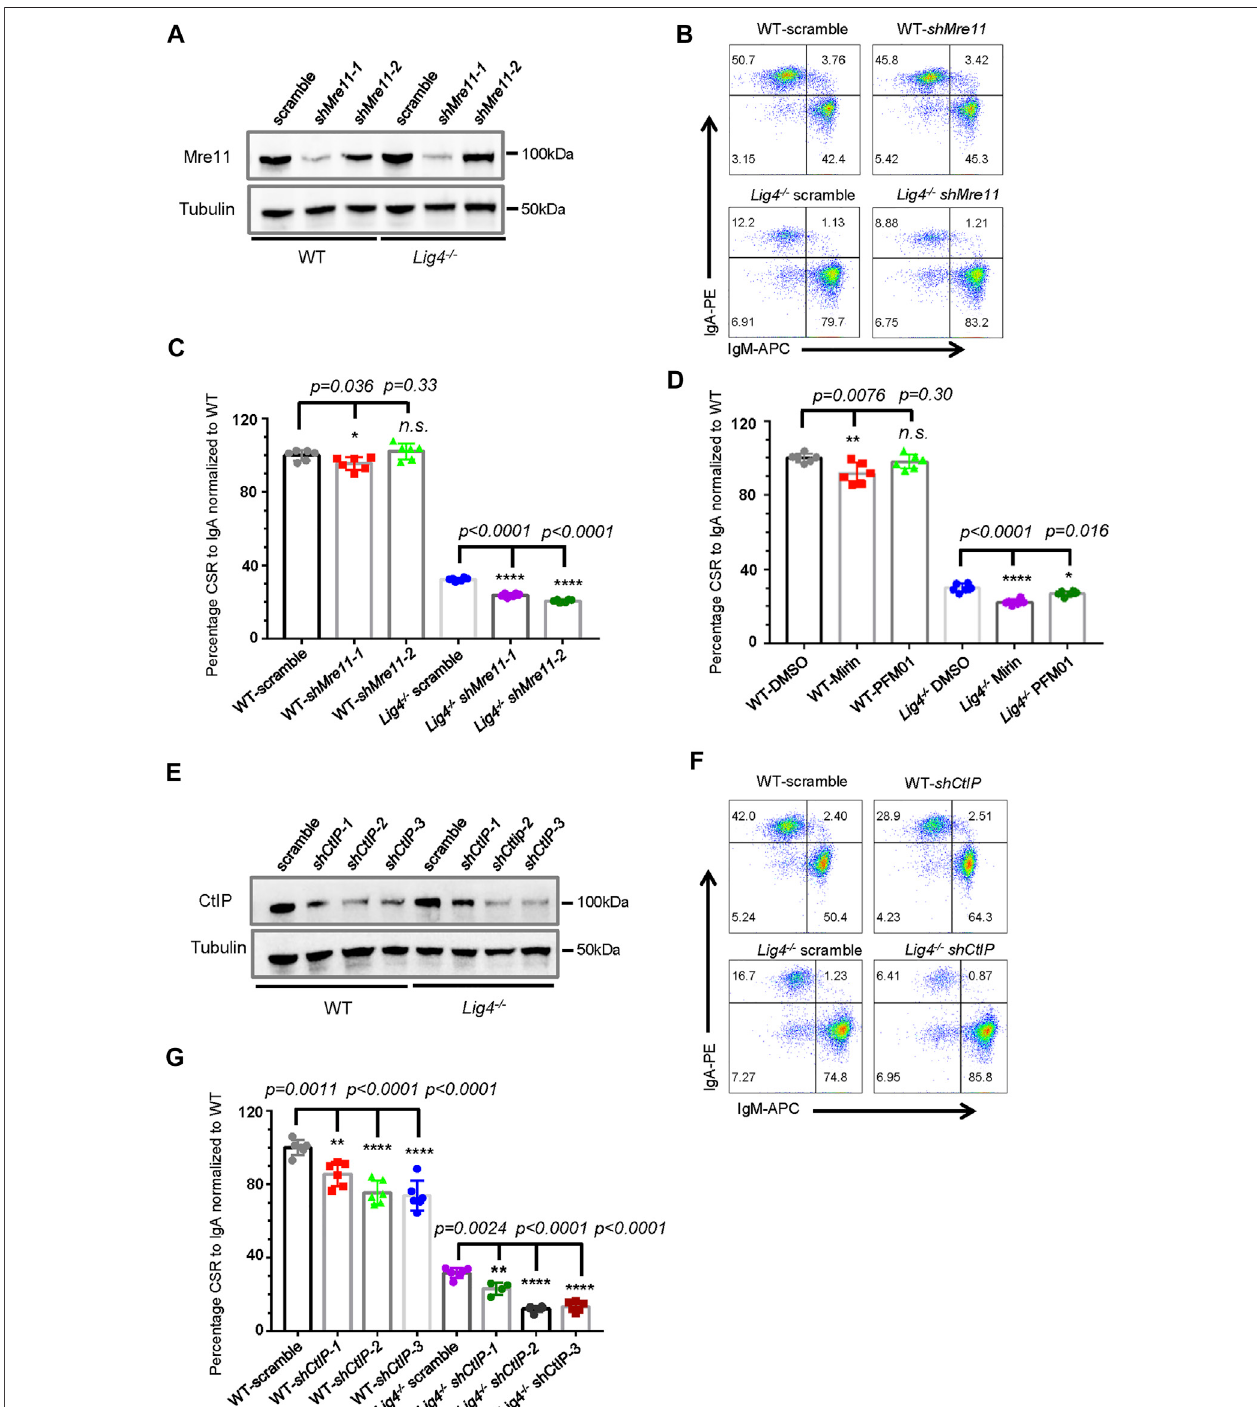
FIGURE 1 | Mre11 and CtIP are essential for A-EJ mediated CSR. (A) Western blot analysis of Mre11 expression in WT and Lig4 − / − CH12F3 cells transduced with lentivirus expressing the indicated shRNA. (B) Representative fl ow cytometry analysis of CSR to lgA in Mre11-silenced WT and Lig4 − / − cells. (C) Quanti fi cation of IgA switching ef fi ciency in Mre11-silenced WT and Lig4 − / − cells normalized to that scramble control. Data were presented as mean ± SD from six independent experiments (Student ’ s t -test, * p < 0.05, ** p < 0.01, *** p < 0.001, **** p < 0.0001, n. s. ( p > 0.05) indicates non-signi fi cant differences). (D) Normalized CSR to lgA in WT and Lig4 − / − cells pretreated with 10 μ M exonuclease inhibitor (Mirin), 10 μ M endonuclease inhibitor (PFM01). Data were presented as mean ± SD from six independent experiments (Student ’ s t -test, * p < 0.05, ** p < 0.01, *** p < 0.001, **** p < 0.0001, n. s. ( p > 0.05) indicates non-signi fi cant differences). (E) Western blot analysis of CtIP